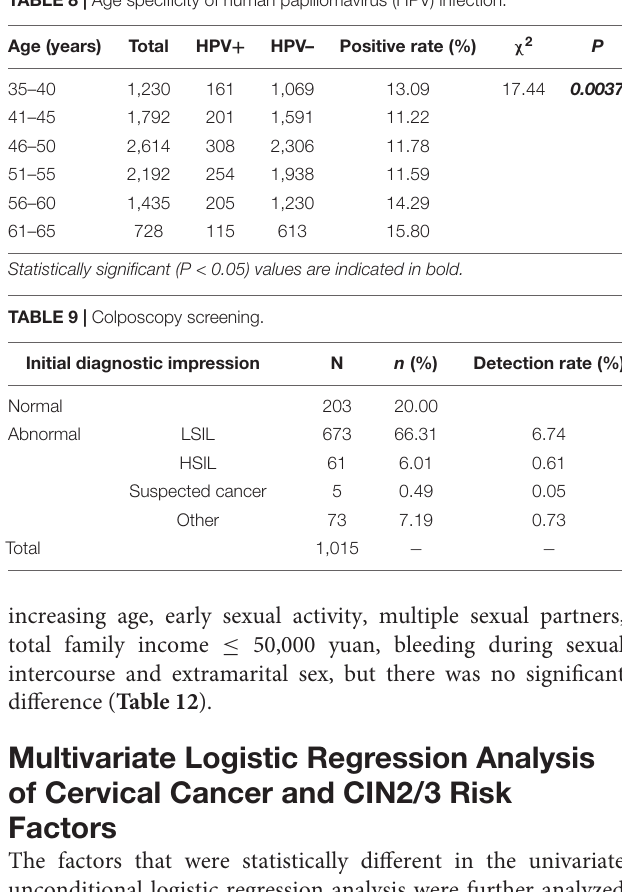
TABLE 8 | Age specificity of human papillomavirus (HPV)